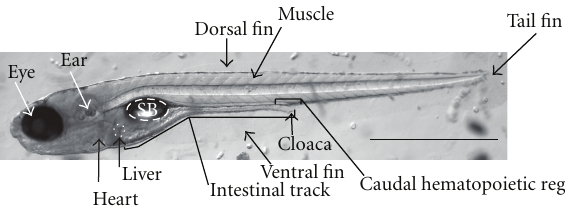
Figure 1: Diagram of zebrafish anatomy. A representative image of a transparent, 6 dpf larvae captured with brightfield microscopy. Organs and anatomical features are denoted in the figure. SB: swim bladder. Scale bar is 1